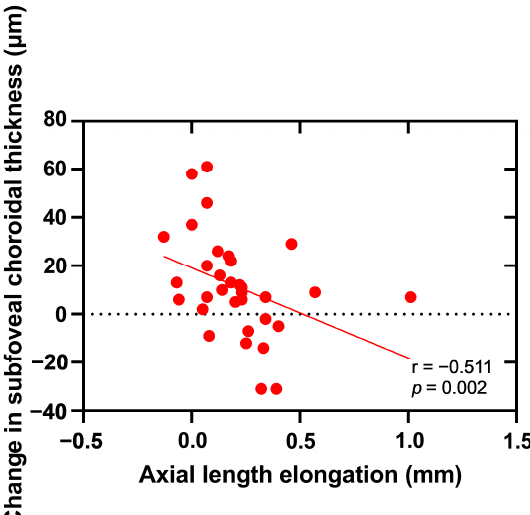
Figure 4. The correlations between the axial length elongation and the changes in the subfoveal thickness at nine-month follow-up.